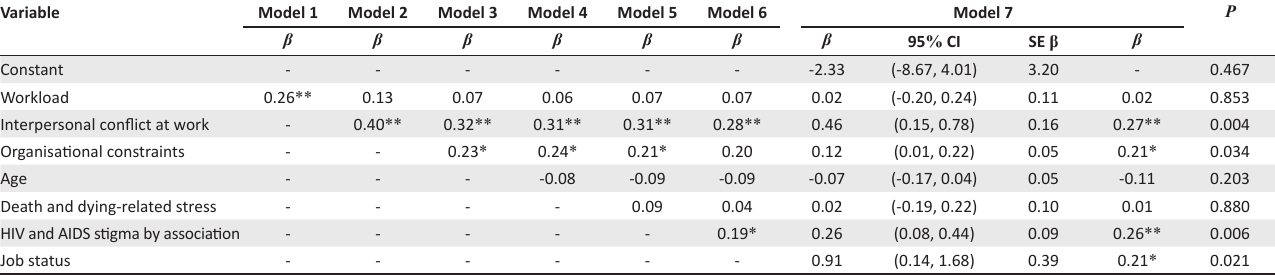
TABLE 5: Predictors of depersonalisation.